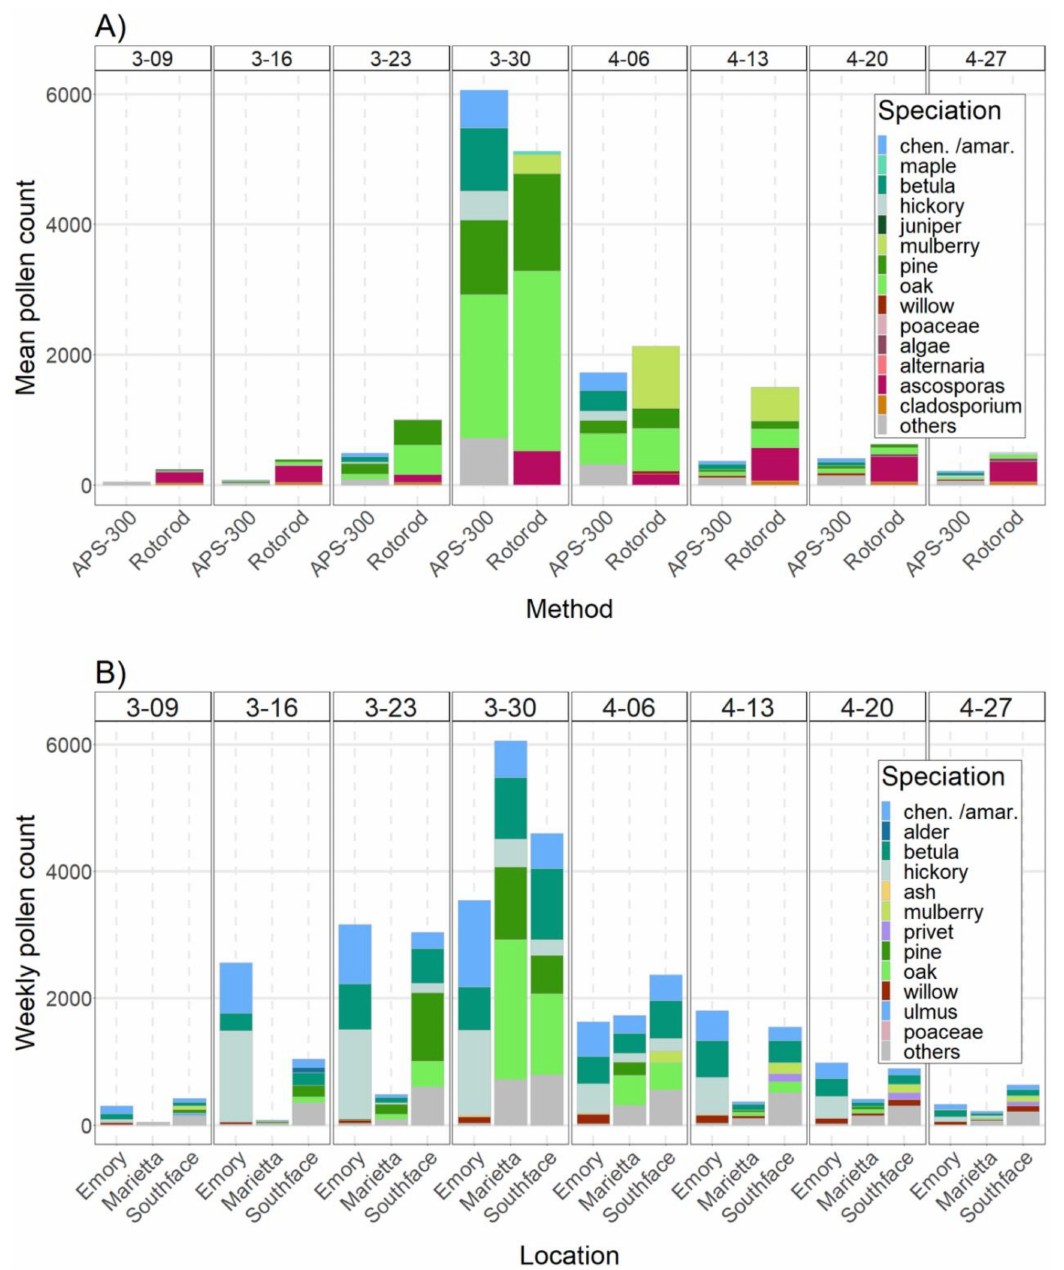
Figure 3. Dominant pollen taxa in the peak season of 2020. Plot ( A )—comparison of dominant pollen taxa measured by Rotorod sampler with manual counting and APS-300 at Marietta site. Plot ( B )—comparison of dominant taxa measured by APS-300 in Marietta, Southface, and